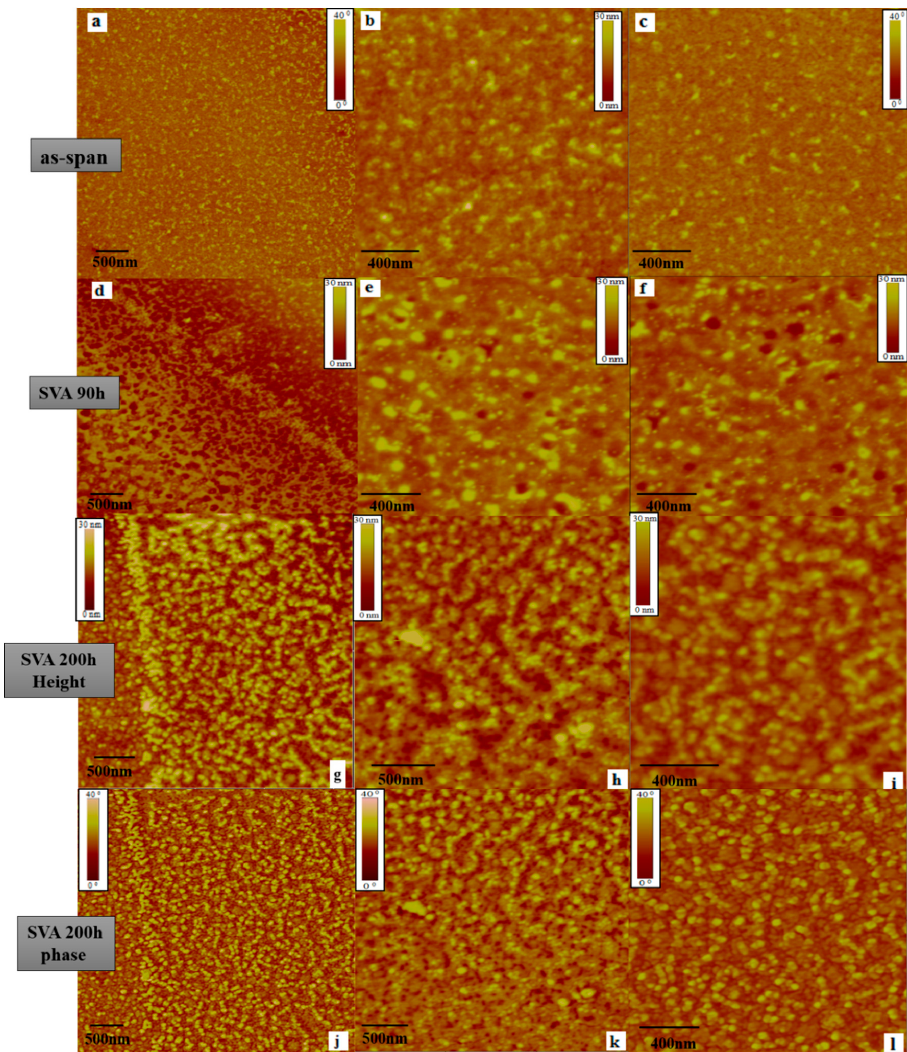
Figure 2. TP-AFM images describe the morphological evolution under SVA treatment of PS 50 -b- PB 50 _PS- γ -Fe 2 O 3 composite. For as-spun state, height and phase ( a,b ) as well as a closer phase views ( c ) are given. Height ( d ) and phase ( e ) as well as closer phase views ( f ) after 90 h are also